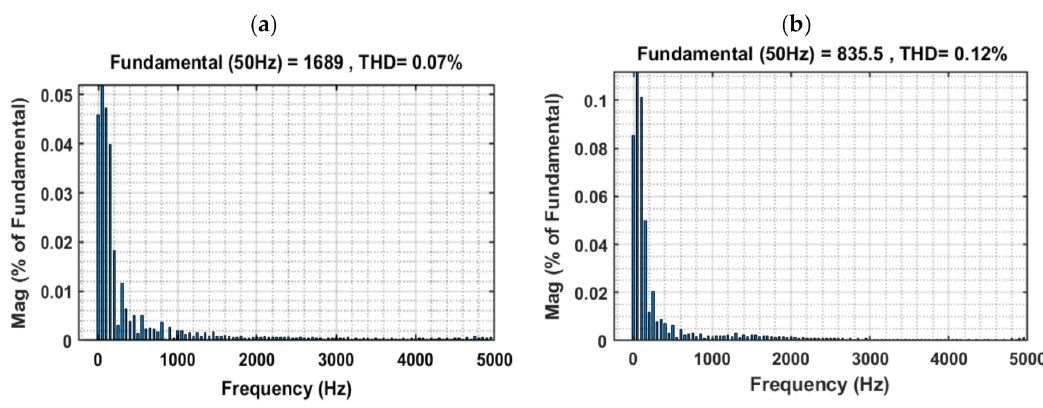
Figure 9. ( a ) Current and ( b ) voltage total harmonic